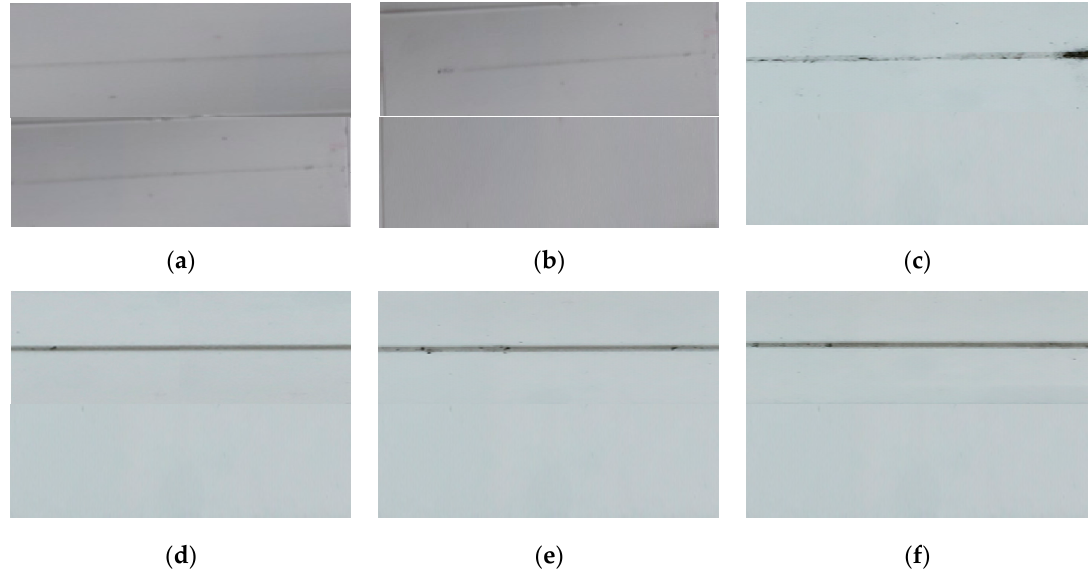
Figure 5. Hardness characteristics of the functional coating film according to the annealing gas, ( a ) is naturally dried, ( b – f ) are annealed with H 2 , N 2 , Ar, O 2 , and in a vacuum, respectively.